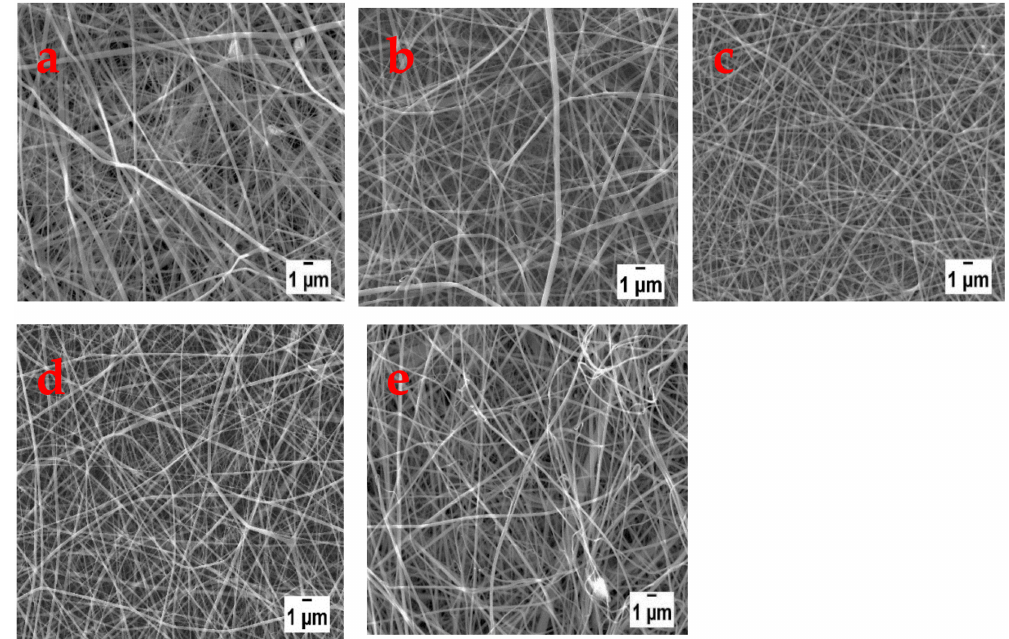
Figure 8. SEM images of nanofibers electrospun at tip to collector distances of ( a ) 6, ( b ) 8, ( c ) 10, ( d ) 12, and ( e ) 14 cm. The SEM images of nanofibers electrospun under optimum conditions are shown in Figure 9 and the corresponding diameter distributions for the nanofibers are shown in Figure 10. The average fiber diameters of 116, 130, 129, and 122 nm were obtained using films from CaCl 2 , Ca(NO 3 ) 2 , LiCl, and LiBr, respectively. The optimum conditions were a flow rate of 6 µ L min − 1 and an applied voltage of 15 kV for all the polymer solutions of the different films. While the polymer concentration of 10 wt% was optimum for CaCl 2 , LiBr, and Ca(NO 3 ) 2 and 13 wt% for LiCl, and tip to collector distances of 12 cm for CaCl 2 and LiBr, 10 cm for Ca(NO 3 ) 2 and 14 cm for LiCl nanofibers.